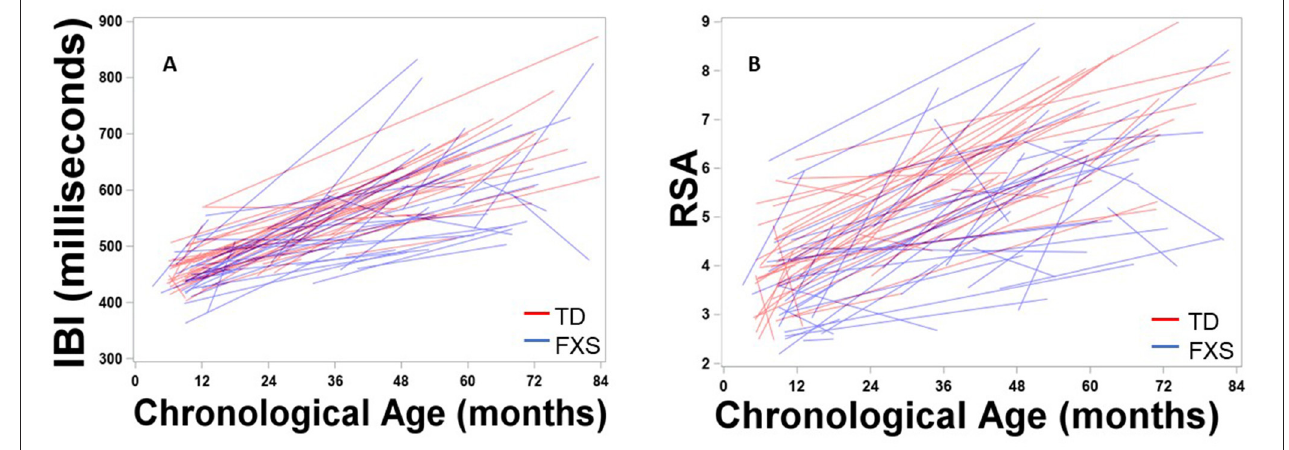
FIGURE 1 | Maturation of (A) IBI and (B) RSA across age within each participant. Males with FXS are indicated in blue; TD males are indicated in red.